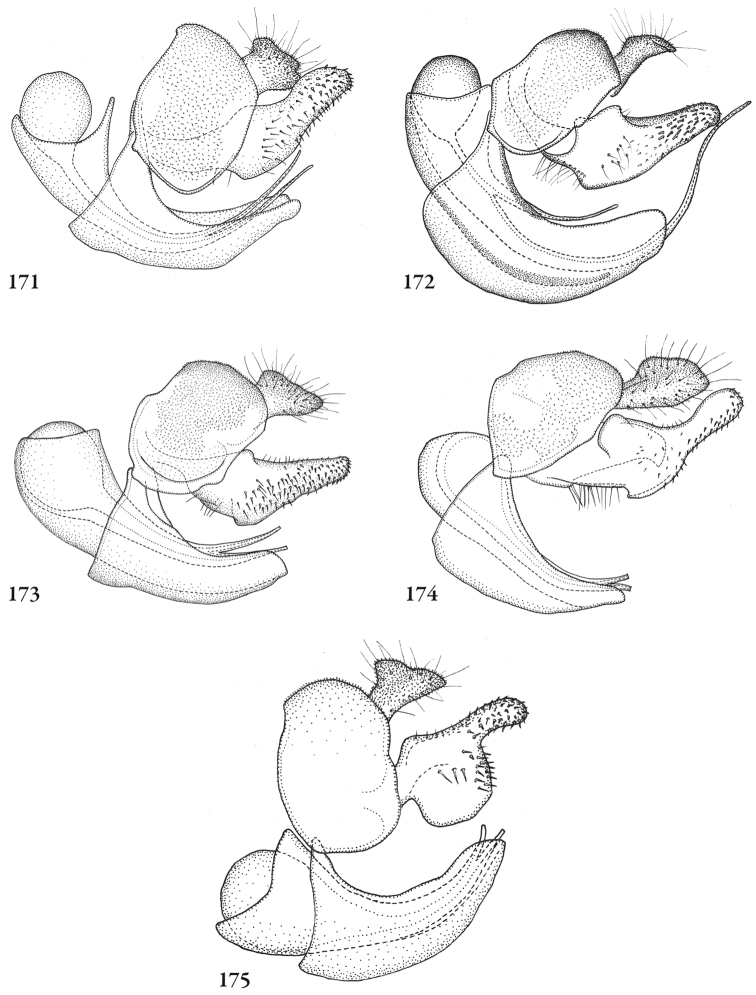
Figures 171–175.
Metadon, male genitalia lateral: 171
Metadon bicoloratus (holotype) 172
Metadon bifasciatus (China, coll. RMNH) 173
Metadon inermis (holotype) 174
Metadon montis (holotype) 175
Metadon punctulatus (holotype).